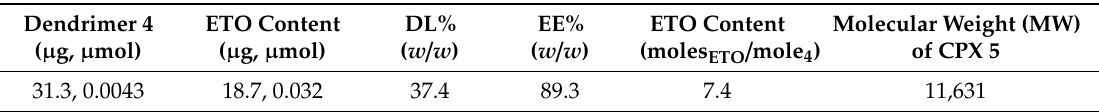
Table 2. Estimated ETO amount in a 50 µ g / mL sample of CPX 5 expressed in µ g, as DL% w / w , as EE% w / w, and as ETO moles (moles ETO ) loaded per dendrimer 4 mole (mole 4 ), and computed molecular weight (MW) of CPX 5